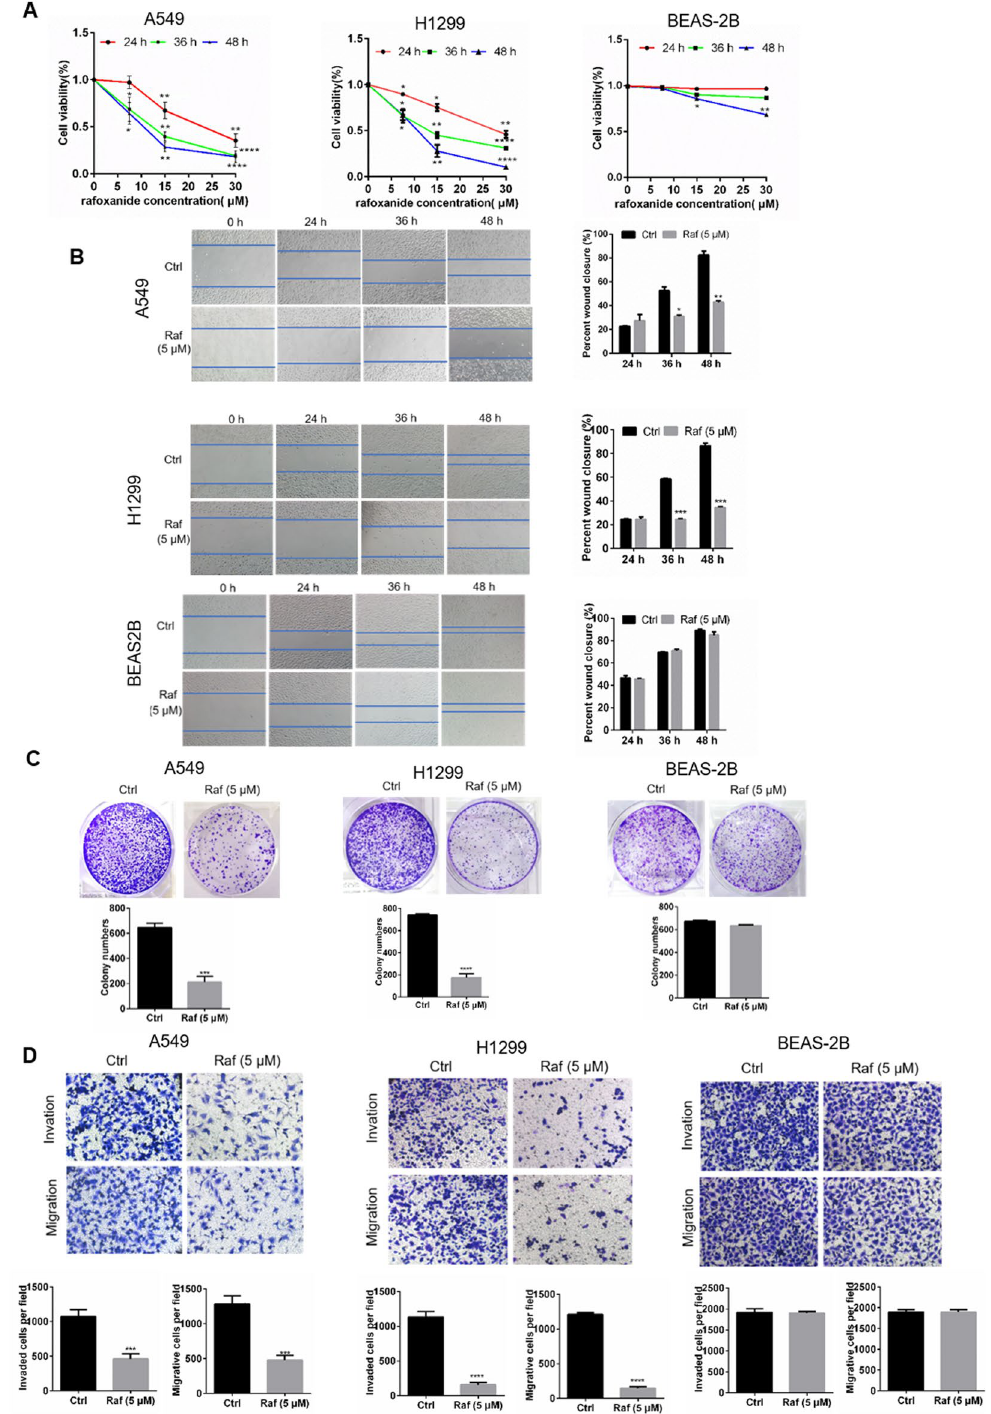
Figure 1. Rafoxanide significantly inhibits NSCLC cells proliferation, migration, and invasion. ( A ) A549, H1299, and HESA-2B cell were treated with rafoxanide at indicated concentration for 24, 36, and 48 h, and cell viability was assessed by the CCK8 assay. ( B ) Colony forming assay of different cells after exposure to rafoxanide (7.5 μM) for 14 days was analyzed. ( D ) The wound healing assay was performed to detect the effect of rafoxanide on A549, H1299, and HESA-2B cell migration at 5 μM. ( E ) The Transwell migration and Matrigel invasion assay were performed to assess cell migration and invasion after treatment with rafoxanide at 5 μM. Data are represented as mean ± SD of three independent experiments. * P < 0.05, ** P < 0.01, *** P < 0.001, **** P <